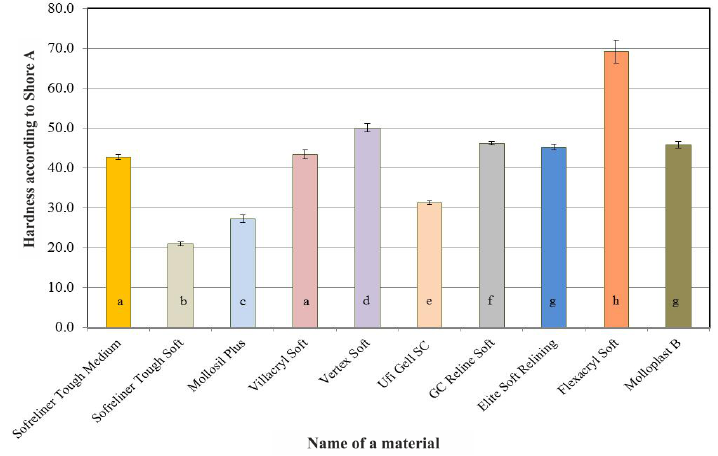
Figure 4. Average Shore A hardness values of the tested relining materials after 60 days of condi- tioning the samples in distilled water. The same letters denote mean values which do not differ statistically significantly.